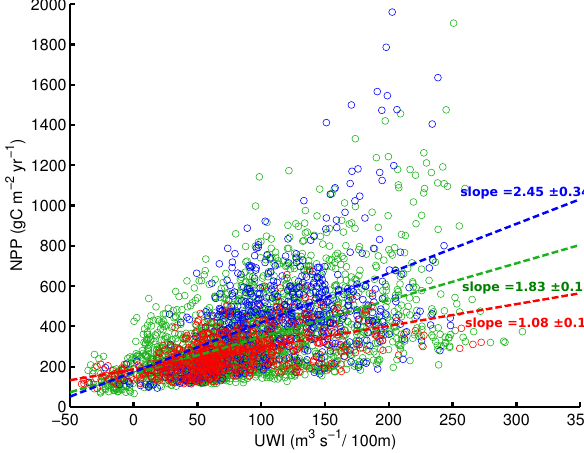
Fig. 12. A sketch illustrating the similarities and differences be- tween the major EBUS. Pie sectors correspond to the 4 EBUS con- sidered. For NPP and each of the 4 drivers, arrows point to ar- eas where these variables reach maximum values (also indicated by saturated colors on the concentric circles). The area of each sector is proportional to the variability of the corresponding EBUS while overlapping sectors illustrate EBUS common features. The sketch shows that the Canary and Humboldt current systems on the one hand and the California and Benguela current systems on the other hand are complementary, meaning each pair represents most of the variability of the 4 EBUS while having little in common. Conversely, the Canary and Benguela current systems on one hand and the California and Humboldt current systems on the other hand are the most similar systems. The Canary and Benguela current systems have in common very productive coastal upwelling condi- tions driven by strong alongshore wind and enabled by a relatively wide continental shelf, low eddy activity and shallow mixed layer. In contrast, the California and Humboldt current systems share in common the least productive conditions with relatively weak along- shore wind, narrow shelf, moderate eddy activity and deep mixed layer. Finally, the region of overlap between the Canary and Cali- fornia current systems indicates similar conditions in the two sys- tems characterized by relatively wide shelf and moderate to high eddy activity. Similarly, the overlapping area between the Benguela and Humboldt current systems illustrates common observations be- tween these two systems characterized by narrow shelf and moder- ate alongshore wind.